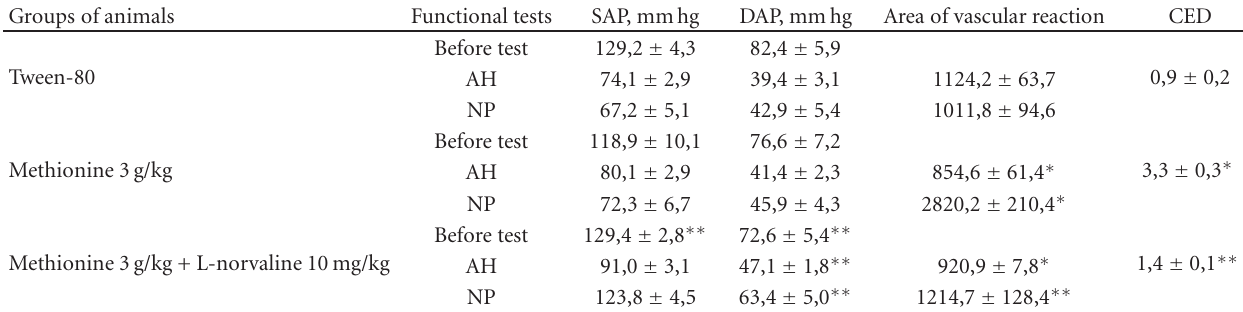
Table 2: Influence of methionine and L-norvaline on indicators of haemodynamics and coe ffi cient of endothelial dysfunction in modeling of the homocysteine-induced NO deficiency (M ± m, n = 10). Groups of animals